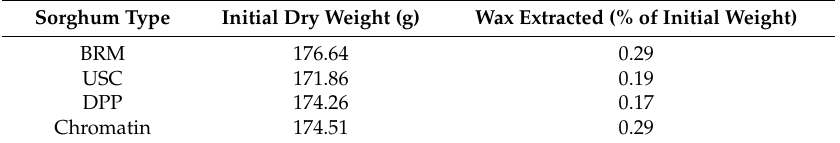
Table 2. Wax contents of four sorghum varieties determined by weight losses during ethanol extraction.